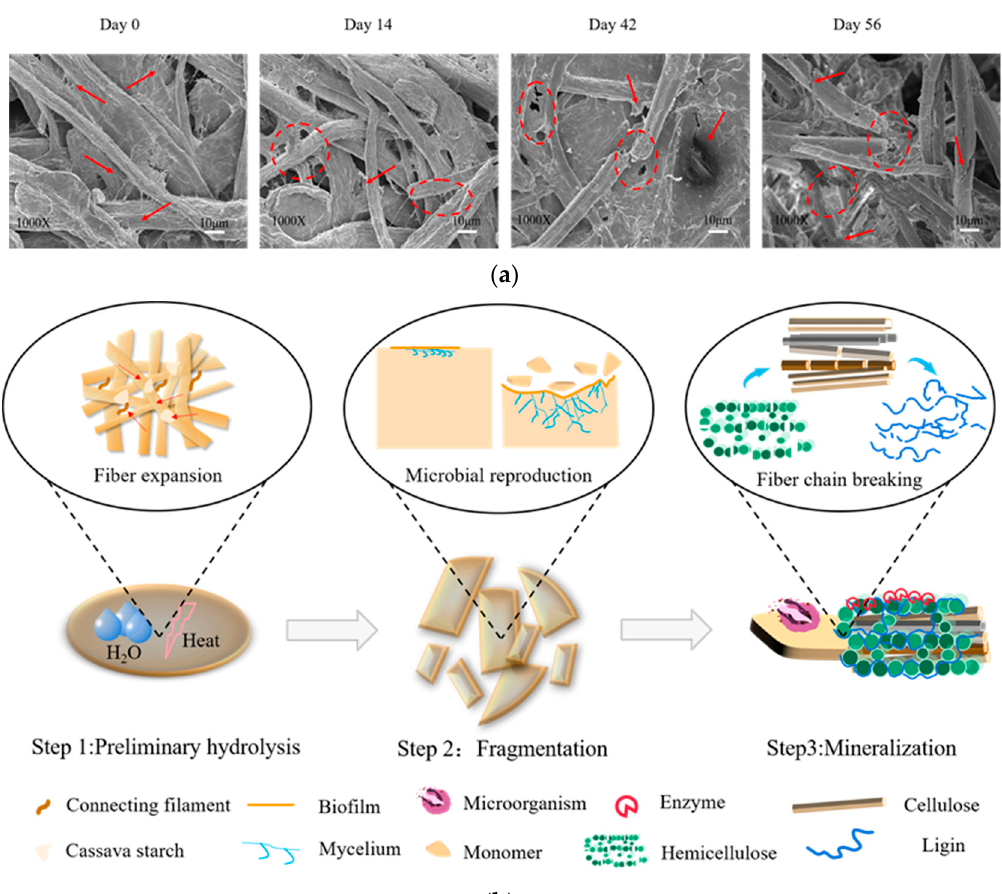
Figure 8. Microscopic images of environment-friendly bamboo fiber lunch boxes in different degra- dation stages: ( a ) microscopic images; ( b ) microscopic degradation process of the bamboo fiber lunch box